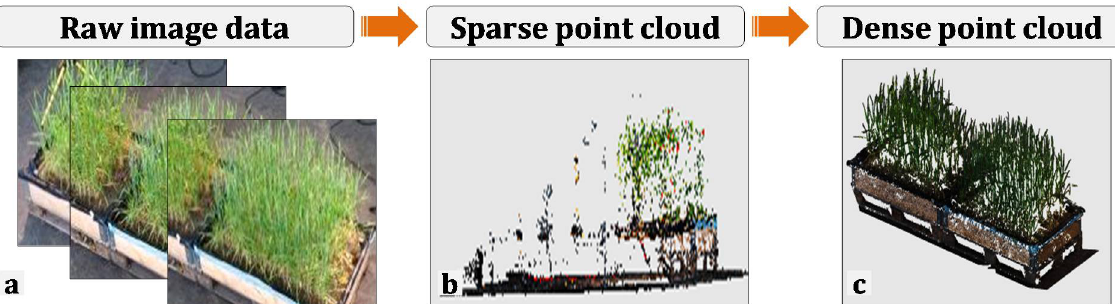
Figure 5. Generation of a 3D dense point cloud showing ( a ) a set of overlapping, uncalibrated raw images captured by digital camera, ( b ) reconstructed images to a 3D sparse point cloud using SfM, and ( c ) recovered result using MVS to a dense point cloud.